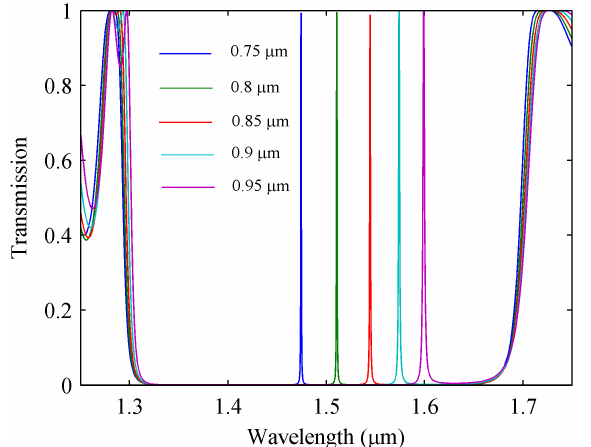
Figure 3. Transmission of the 1-D photonic crystal air nanocavity for d Si = 0 . 52µm and d Air = 0 . 42µm. Different modes oscillate for cavity lengths of 0.75–0.95µm (from left to